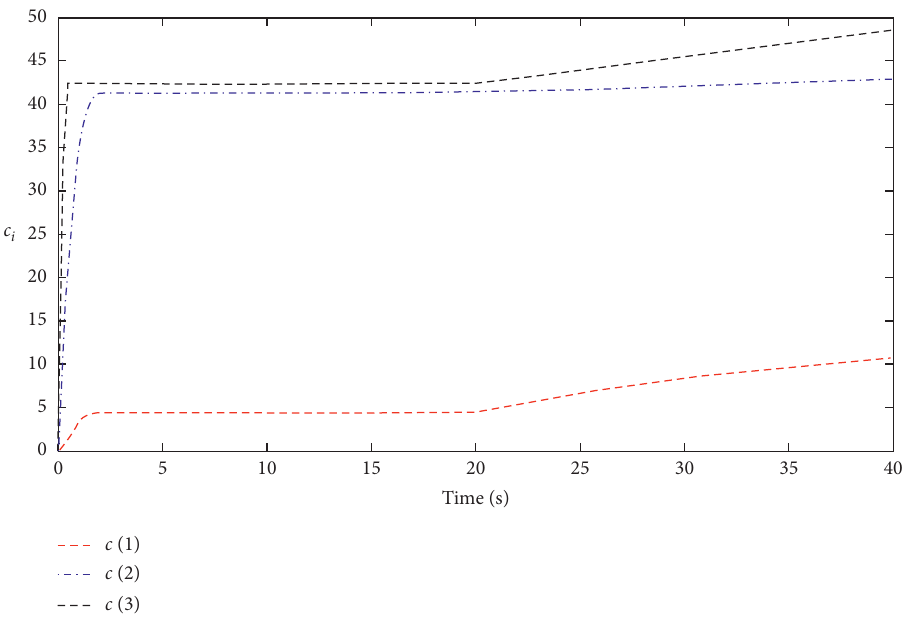
Figure 13: The output of the robust adaptive strategy with